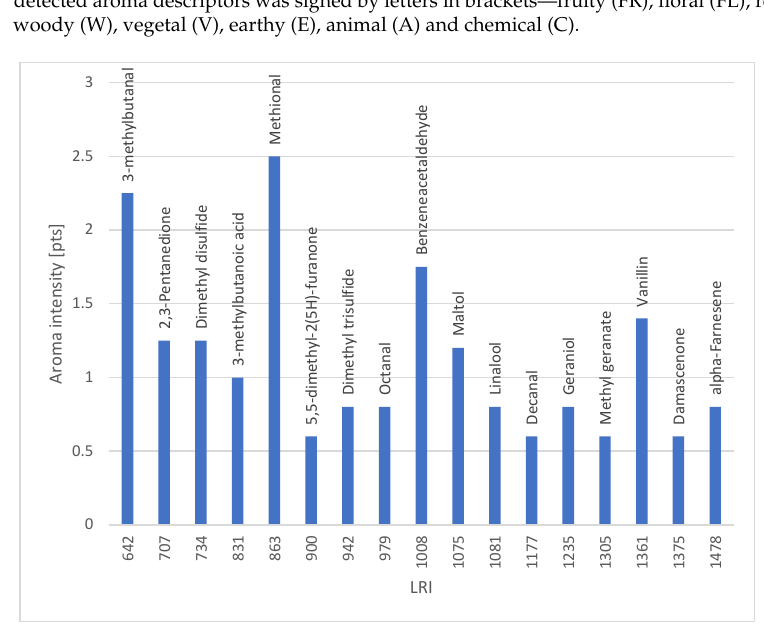
Figure 2. Odour-active compounds and their intensities in hopped unfermented wort.